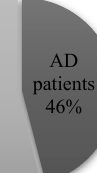
Figure 4. Distribution of the population by degree of AD. 2.2.2. Human Interviewer The recordings of the samples were carried out by one member of the investigation team using an Intel Core i5, 12 GB RAM. 250 Gb SSD laptop, where different recordings have been stored. Furthermore, Audacity ® software has been used to carry out the record- ing and the Ozone Rage ST [102] headset with microphone. When conducting the inter- view, each of the subjects has been asked or encouraged to talk about what they want, about a free topic, with the objective of achieving a spontaneous speech recording that varies between 30 s and 2 min. 2.2.3. Automatic Interviewer The obtained samples of the automatic interviewer are gained by the Prognosis soft- ware. The main objective of this software is to make recordings based on the “automatic interviewer”. In order to obtain these samples of induced speech and to incite the subjects to speak, a series of videos have been used as stimulus, taking into account that the com- mon denominator of all the participants is age and that they are all over 65 years old. In the Portal Memoria Digital de Canarias of the University Library of the ULPGC [103] there is a wide repertoire of reports and old news, among others, that we have used to provoke reminiscences in the subjects. Currently, there are numerous studies that demonstrate the effectiveness of the use of multimedia tools, such as videos, to make subjects who suffer from dementia or AD communicate or express themselves more easily [104]–[107], and they are also especially interesting when they are personalized or provoke reminiscences of moments lived. Based on this, we have expressly selected from the repository those